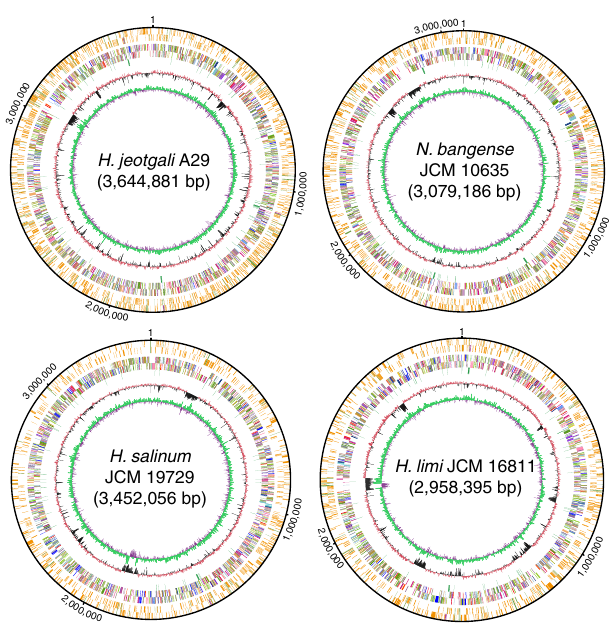
Fig. 2 Phosphorothioate (PT) mapping across the genomes of H. jeotgali A29, N. bangense JCM 10635, H. salinum JCM 19729 and H. limi JCM 16811. From the outer to the inner circles: circles 1 and 2 (forward and reverse strands), PT sites in ORFs (orange), noncoding RNA (purple), and nonencoding regions (green); circles 3 and 4, predicted protein-coding sequences coloured according to COG functional categories; circle 5, tRNA/rRNA operons; circle 6, guanine-cytosine content; and circle 7, guanine-cytosine skew. Source data are provided as a Source Data fi